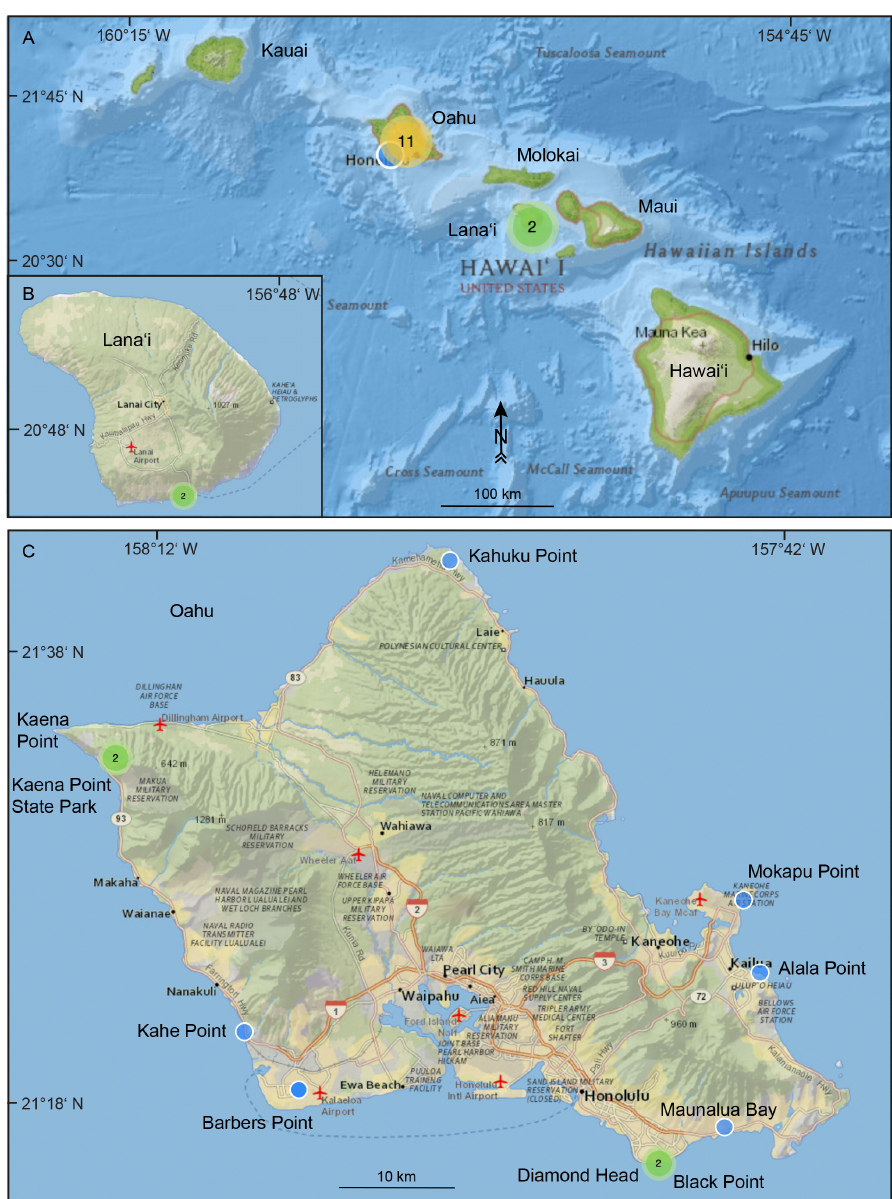
Figure 13. Map showing islands in Hawaii considered in this article (green and orange circles). Study sites on Lanai and Oahu are indicated by blue and green circles. Basemap: “National Geographic Map”, with data from National Geographic, Esri, Garmin, HERE, UNEP-WCMC, USGS, NASA, ESA, METI, NRCAN, GEBCO, NOAA and INCREMENT P